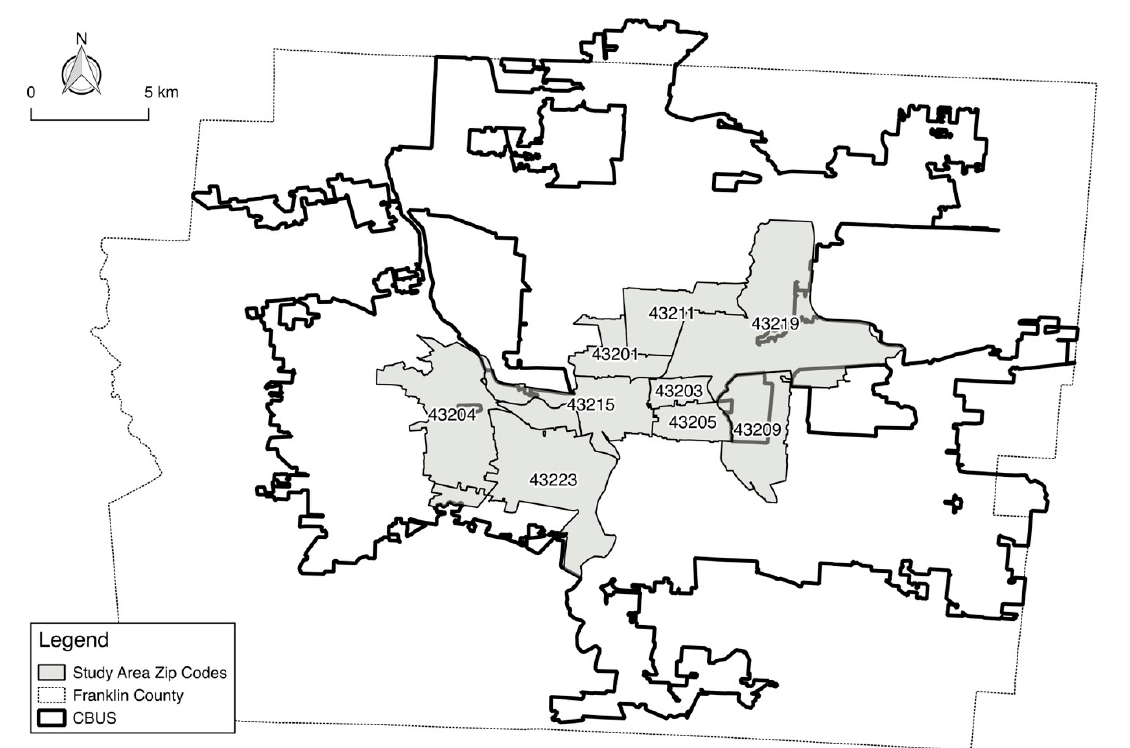
Figure 2. Study area. Note. CBUS: The boundary of the City of Columbus, Ohio.